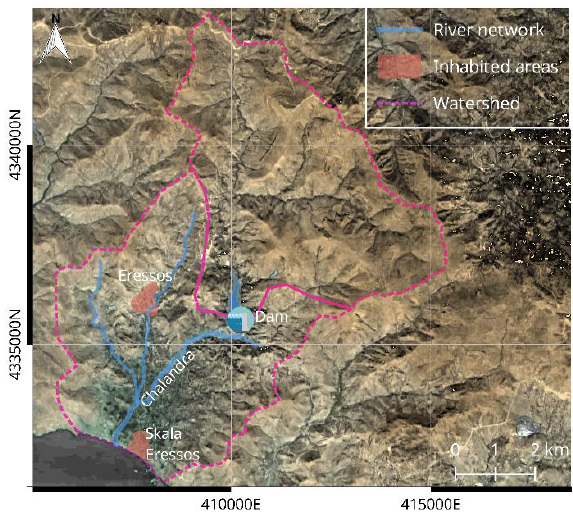
Figure 2. Study area. Background image results from the combination of an optical image (Landsat-8) and the SRTM DEM aspect map. Reference system is WGS84 UTM 35N.